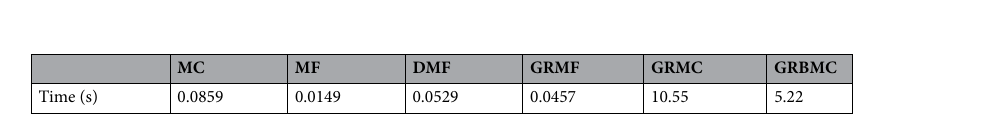
Table 5. Running time of the DVA computational